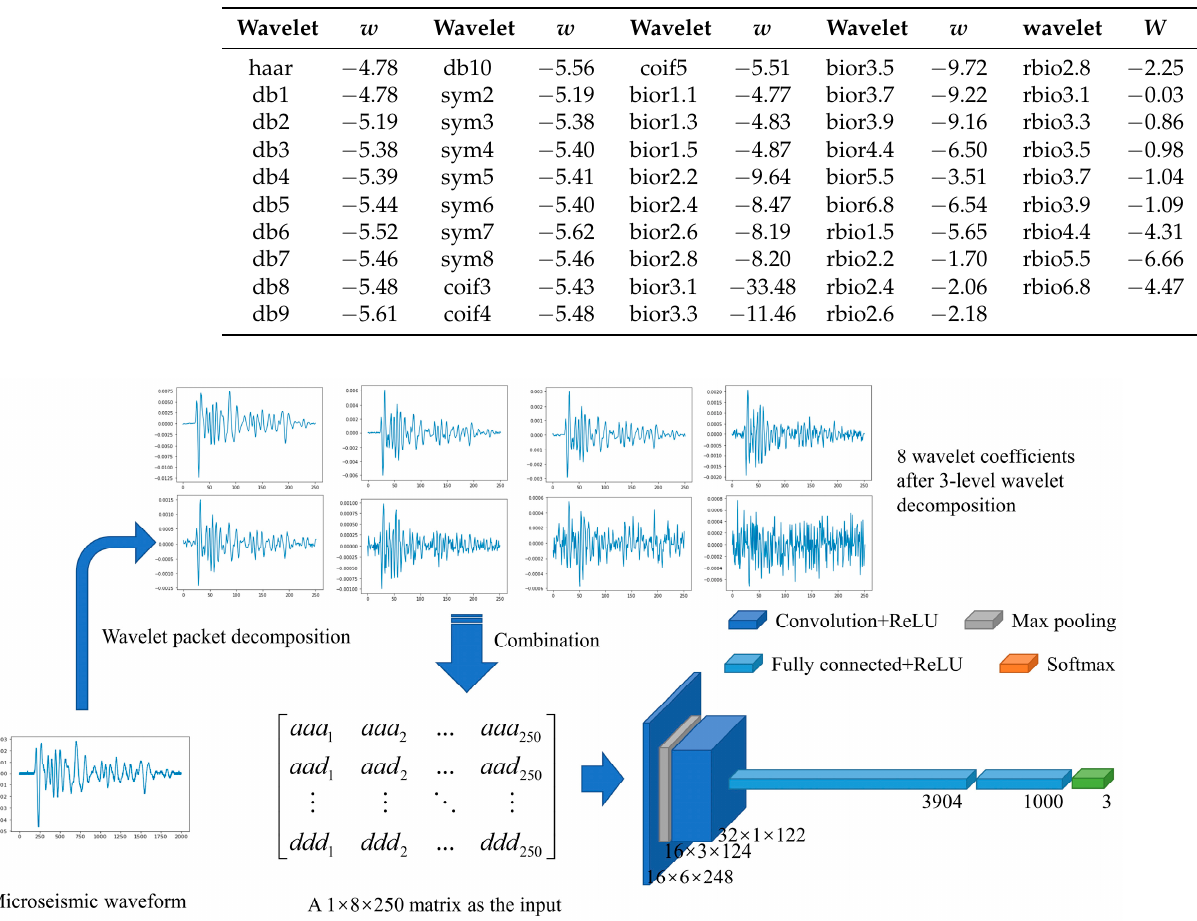
Figure 6. Automatic classification of microseismic signals using wavelet packet decomposition and deep learning. After performing a 3-level wavelet packet decomposition, the eight wavelet coefficients can be obtained from the mining-induced microseismic waveform. These wavelet coefficients are formed into a feature matrix adopted as input for training the convolutional neural network.